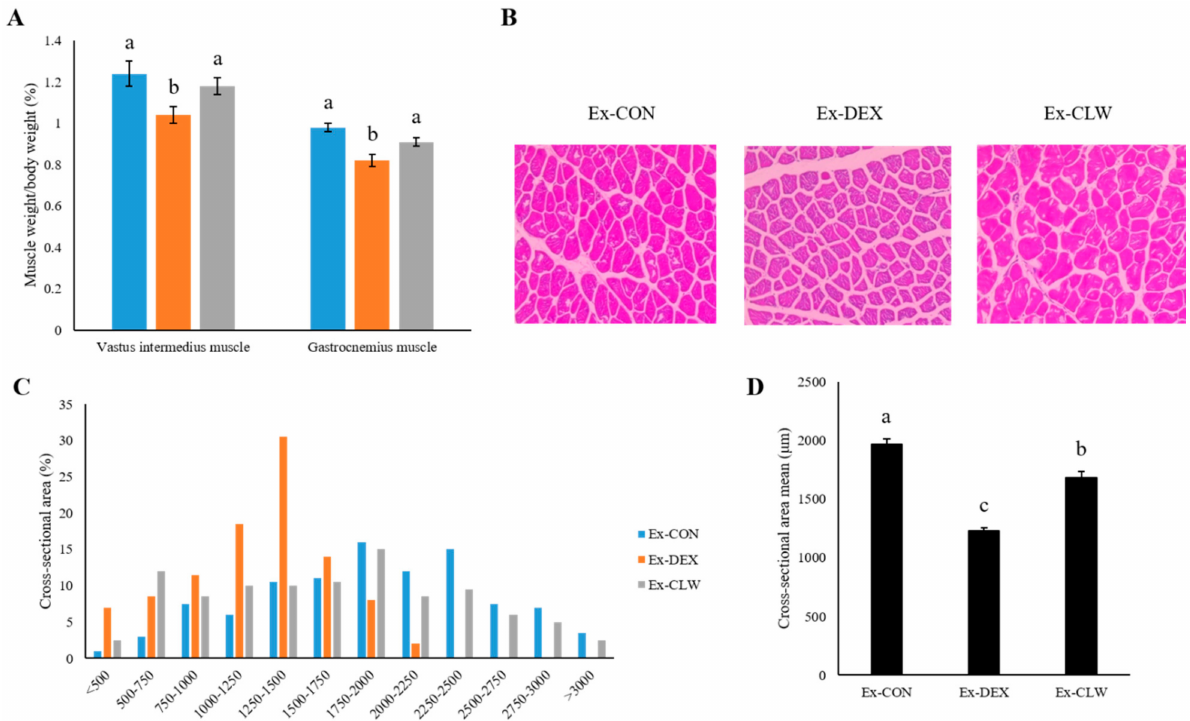
Figure 2. Effect of CLW on DEX-induced muscle atrophy. Ex-CON, DW-supplementation and saline IP injection group; Ex- DEX, DW-supplementation and DEX (1 mg/body weight/day) IP injection group; Ex-CLW, CLW supplementation (1 g/body weight/day) and DEX IP injection group. ( A ) Relative weight of the DEX-induced muscle after CLW supplementation in each mouse. ( B ) Representative hematoxylin and eosin-stained section of the gastrocnemius muscle. Images were analyzed by microscopy and the cross-sectional area (CSA) was measured ( × 200). ( C ) Distribution of the muscle fiber CSA. ( D ) Cross-sectional area mean. Data are expressed as mean ± SE for eight mice in each group. Values with different superscripts indicate a significant difference among groups based on Duncan’s multiple range test ( p <